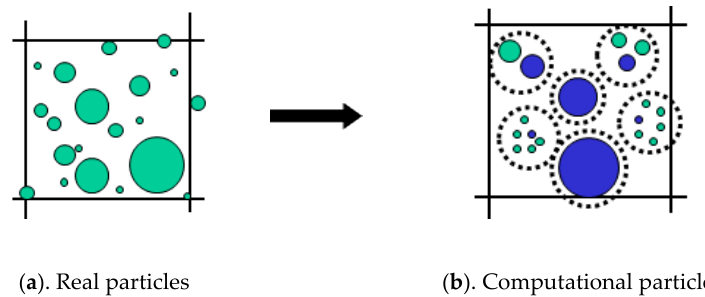
Figure 5. Schematic diagram of real particles and computational particles.